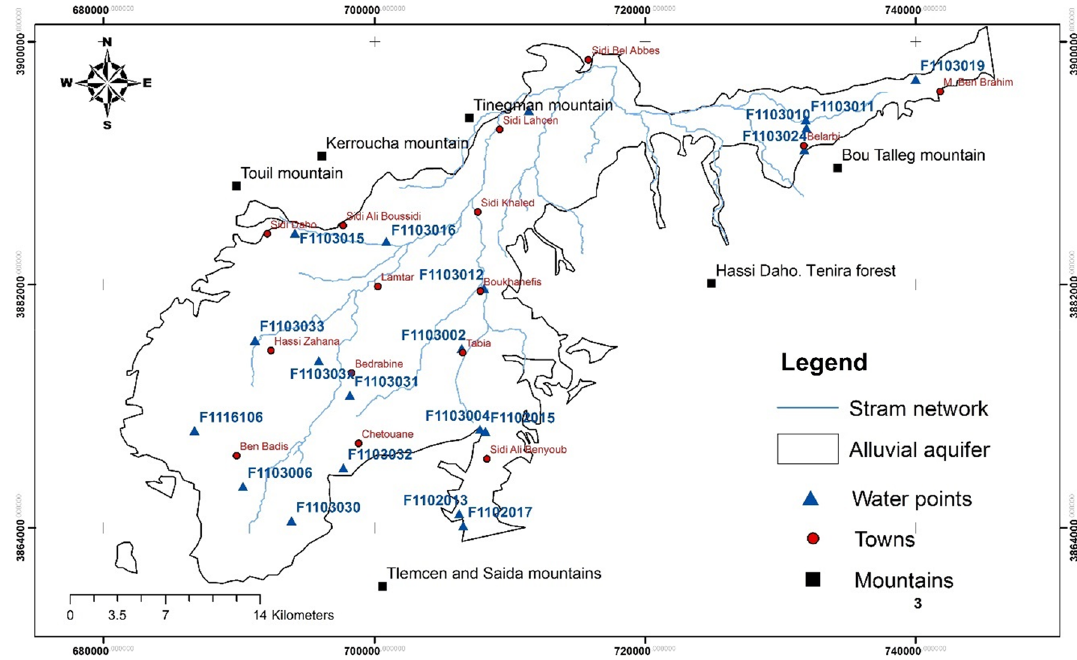
Fig. 4 Spatial distribution of water